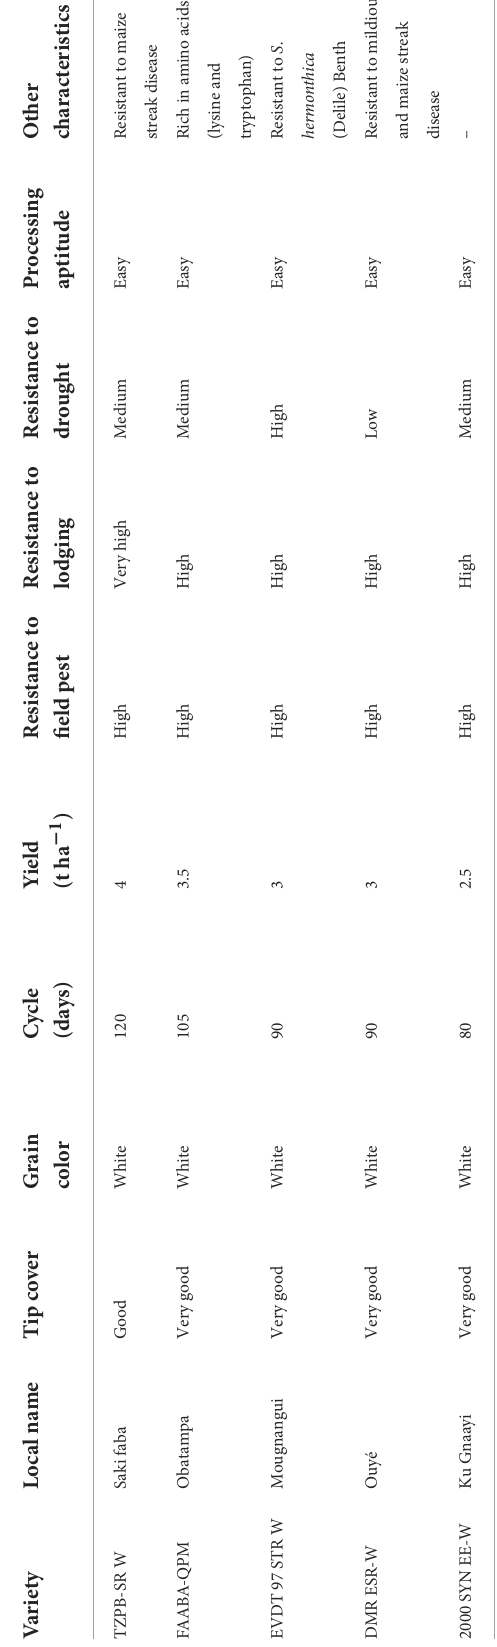
to phytogeographical zones (Kruskal–Wallis test, p < 0.001; Figure 5B). Seed producers in the Guinean zone produced maize seeds on a small area (2.67 ± 1.49 ha), while in Sudanian zone seed producers cultivated on a large area (10.03 ± 6.76 ha). Sowing was performed at a density of 62,500 plants/hectare with 2 seeds per hole (0.80 × 0.40m), and foundation seeds were supplied by INRAB’s research centers (40.74% of producers), ATDA (28.39% of producers) or seed farms (12.34% of producers). For soil fertilization, two types of fertilizers were used: NPKSB (14–23–14–5–1) or NPK (10–20–20), applied before sowing or after sowing (15 days after sowing) at a rate of 200kg ha − 1 , and urea (46% N), applied at a dose of 100 kg ha − 1